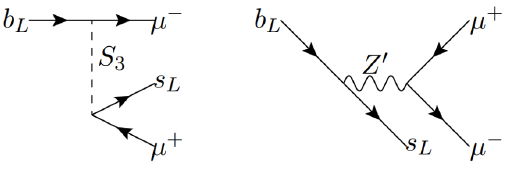
Figure 1 . Tree-level Feynman diagrams of the new physics contributions to the b → sµ + µ − observables in a suitable scalar S 3 leptoquark model (left panel) and in a suitable Z 0 model (right